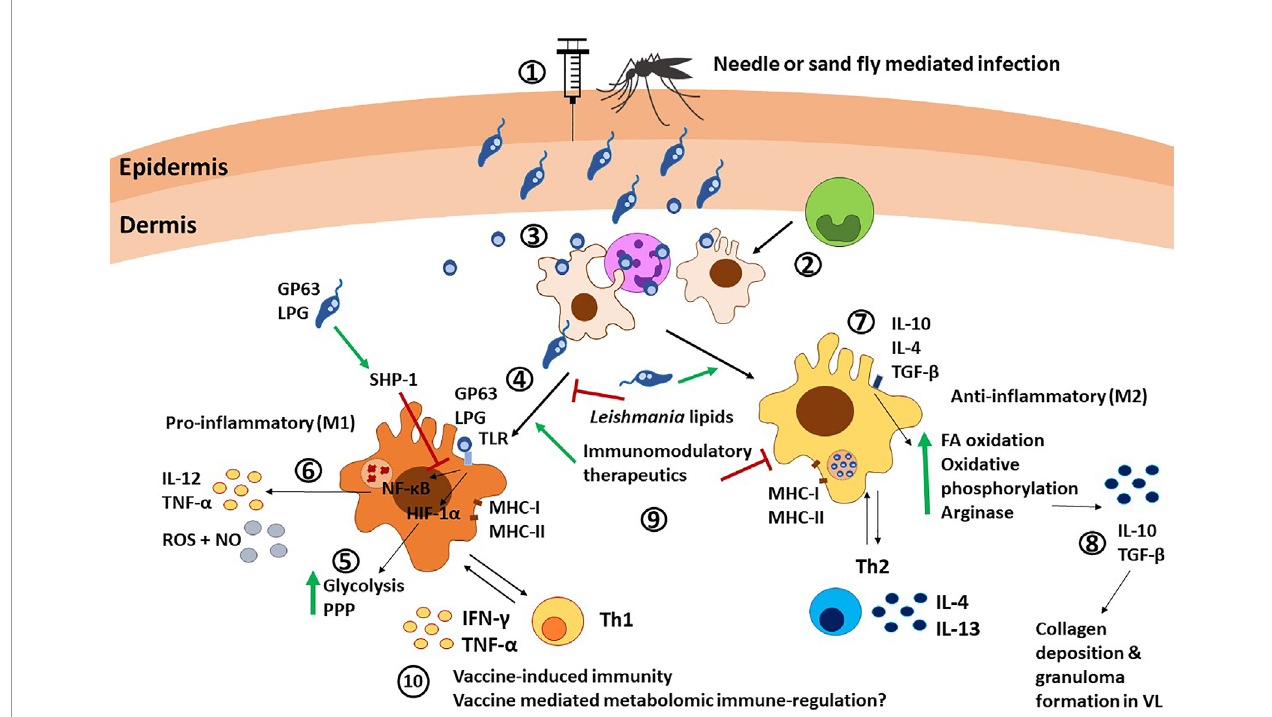
FIGURE 3 | Macrophage immunity against Leishmania parasites. 1) Leishmania promastigotes are injected into the host via needle injection or sand fl y injection. 2) Monocytes differentiate into macrophages at the infection site. 3) Macrophages are recruited by neutrophils and infected after neutrophils release Leishmania parasites, or as a consequence of phagocytosis of necrotic neutrophils. 4) Macrophages are the canonical host for Leishmania and can polarize towards M1 after TLR stimulation via Leishmania molecules such as LPG and GP63. 5) TLR signaling induces HIF-1 a and subsequent upregulation of glycolysis and the pentose phosphate pathway (PPP). 6) TLR signaling also leads to NF- k B translocation to the nucleus and subsequent release of IL-12, TNF- a , and NO. SHP-1 upregulation by the parasite GP63 and LPS can interfere with this pathway. 7) On the other hand, stimuli such as IL-10, IL-4, and TGF- b can polarize macrophages towards an M2 anti-in fl ammatory phenotype, characterized by upregulation of fatty acid (FA) oxidation, oxidative phosphorylation and arginase production. 8) M2 macrophages produce IL-10 and TGF- b , which mediate collagen deposition and granuloma formation in VL. 9) Different factors such as Leishmania -derived lipids, immunomodulatory therapeutics and Th cells can induce and alter macrophage polarization. 10) The interplay between macrophages and Th1 cells via antigen presentation and cytokine release is involved in vaccine-induced immunity. Furthermore, metabolomic reprogramming could in fl uence vaccine immunity, as shown in BCG vaccine, although this remains underexplored in Leishmania . PPP, pentose phosphate pathways; FA, fatty acid; NO, nitric